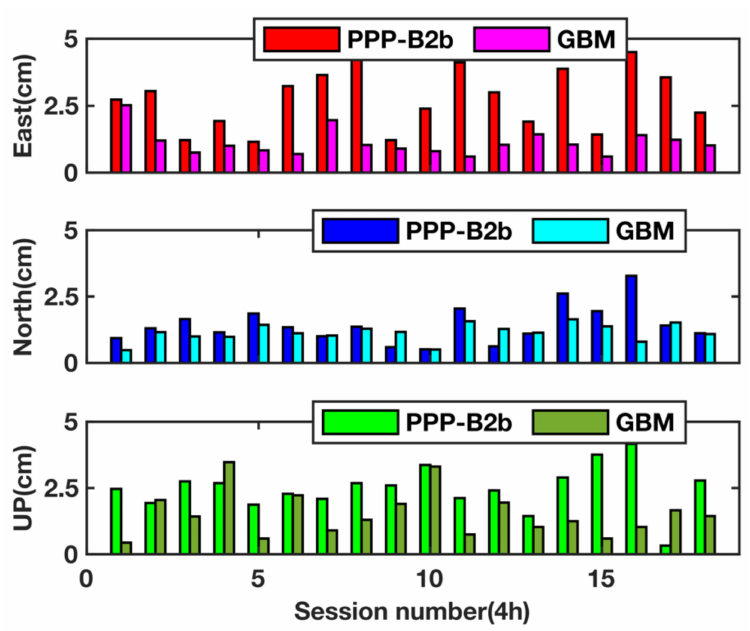
Figure 11. Positioning accuracy of static PPP with different data sessions at SHA1 station. Convergence time (CT) is also a crucial factor to assess the static PPP performance. As described in the official document [7], the positioning performance with PPP-B2b service is better than 30 cm in the horizontal component and better than 60 cm in the vertical component with a confidence level of 95%. Hence, the convergence time was defined to achieve the horizontal positioning accuracy better than 30 cm, the vertical positioning accuracy better than 60 cm, and keep such a positioning accuracy at least 5 min in this paper. The convergence time of static PPP at each iGMAS station is shown in Figure 12. As visible, the convergence time with PPP-B2b service is 18.0/17.0/18.8/16.9 min at 4 iGMAS stations. When GBM products are used, the convergence time is 8.2/11.8/10.6/9.8 min, respectively.